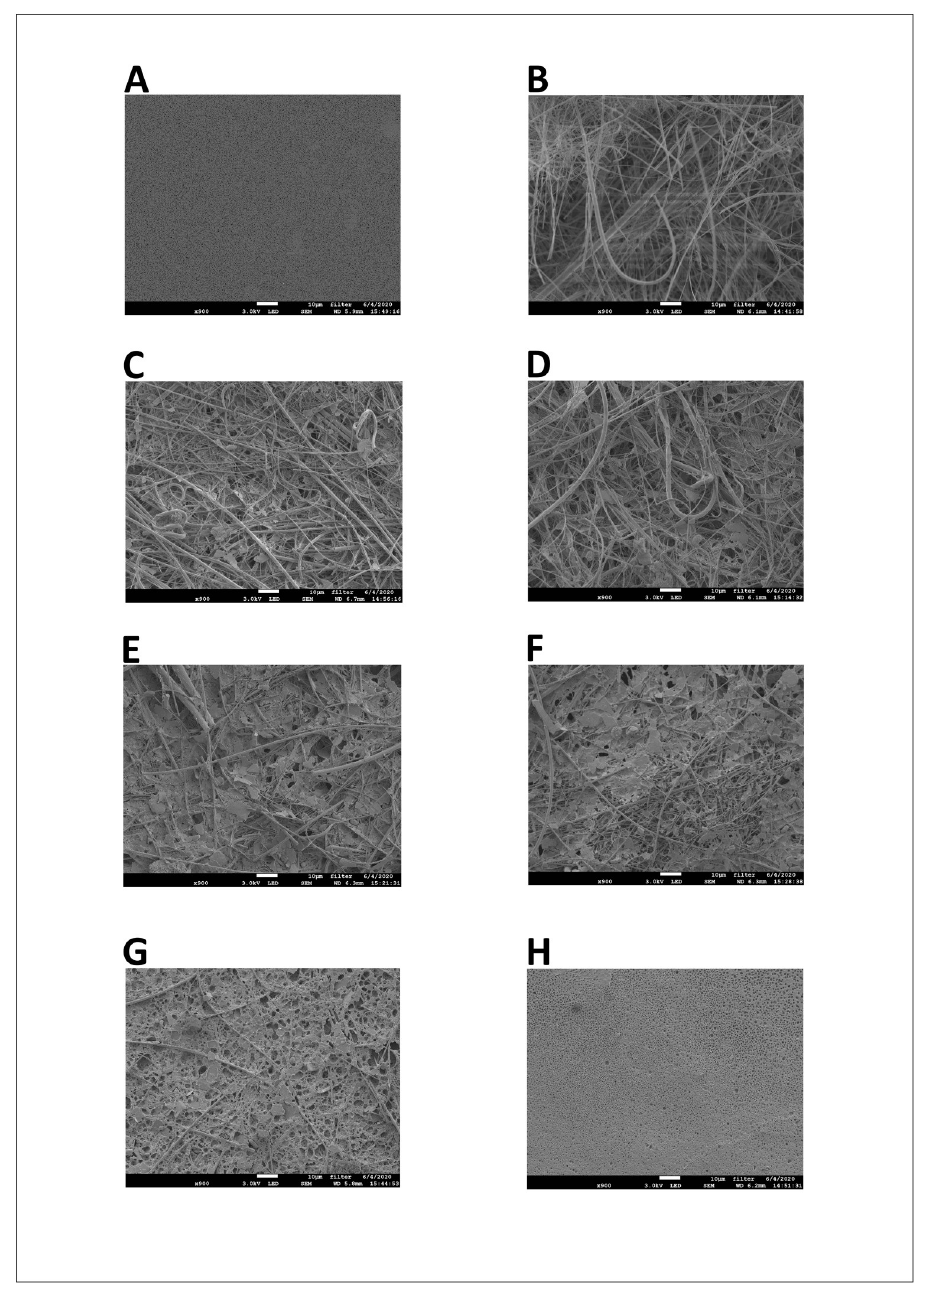
Fig 3. SEM of membrane surfaces coated with various layers of PHB. The Isopore Membrane Filter is shown in the native, uncoated state (A). GMF filters are shown either without coating (B), or with 1 (C), 2 (D), 3 (E), 5 (F), 10 (G) and 15 (H) layers of PHB. Each picture is shown at 900X magnification, with 10 μ m bar.